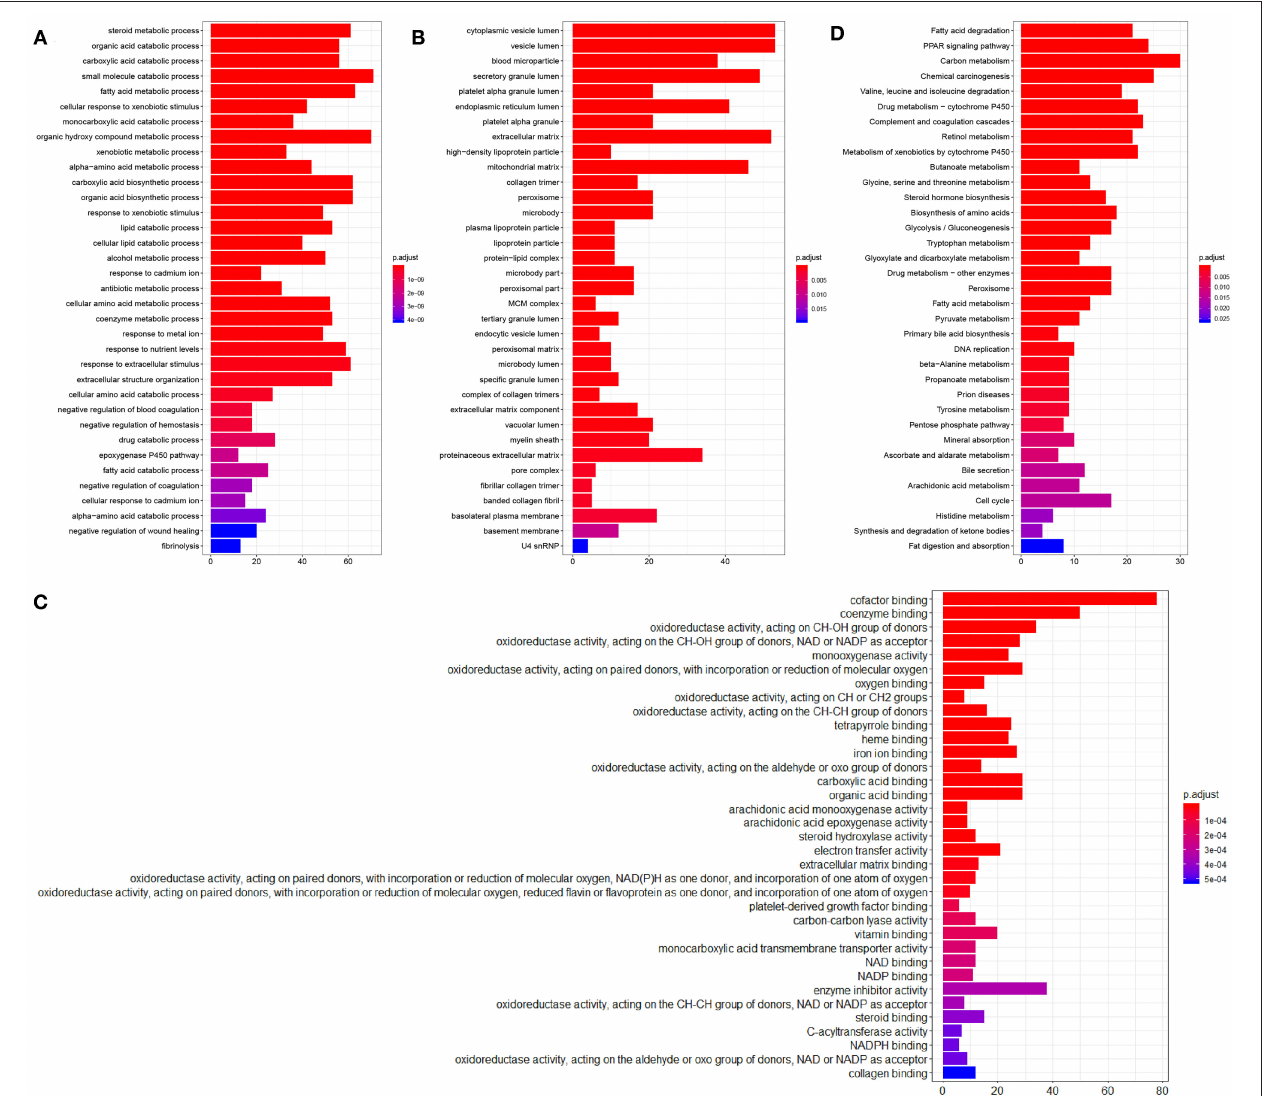
FIGURE 2 | Enrichment analysis of the differentially expressed genes. (A) , GO (BP) enrichment analysis of the differentially expressed genes. (B) , GO (CC) enrichment analysis of the differentially expressed genes. (C) , GO (MF) enrichment analysis of the differentially expressed genes. The X-axis represents the number of genes, the Y-axis represents the functional items, and the histogram on the right is the color scale. (D) , KEGG metabolic pathway enrichment analysis of the differentially expressed genes.